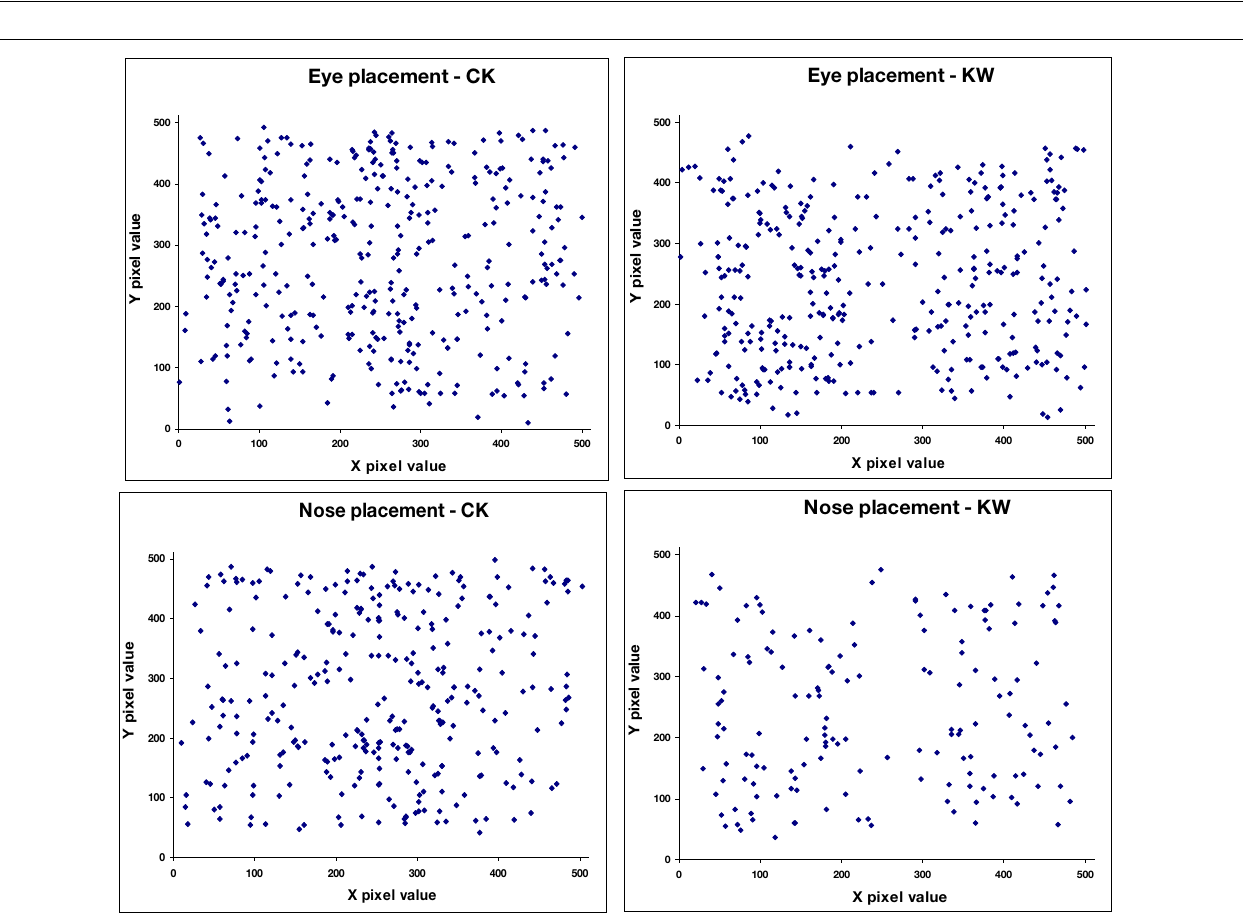
FIGURE 7 | Perceived location of eyes and nose in faces in the symmetric images with asymmetric contrast, illustrated for two observers. Top: eye positions (center pixel); bottom: nose positions.